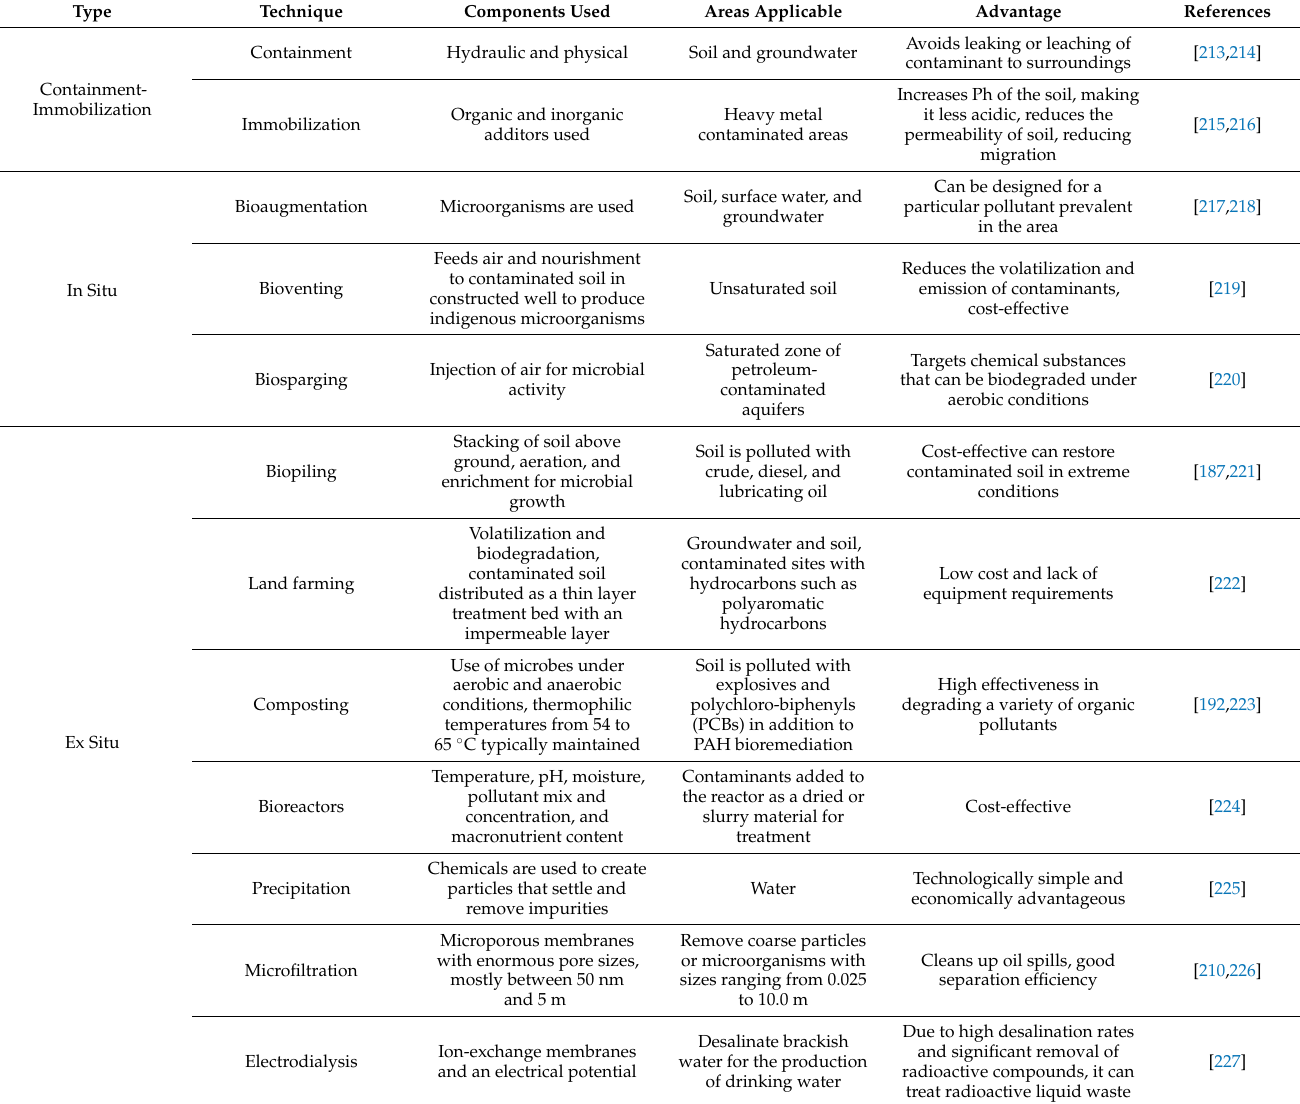
Table 2. This table summarizes the updated remediation technologies and their characteristics for controlling the contamination of each type of